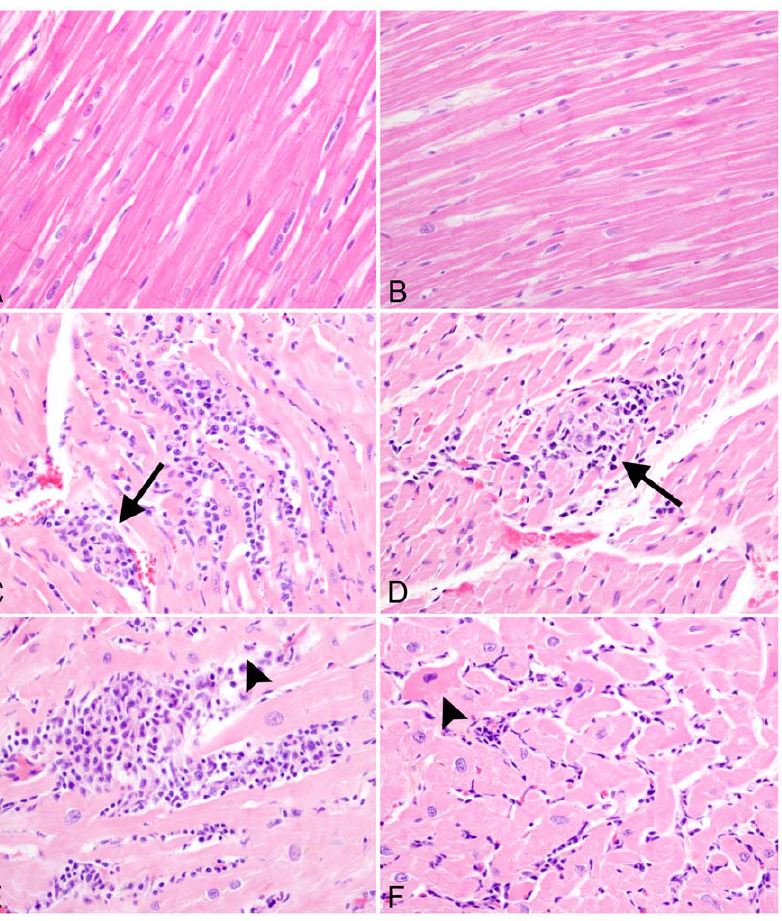
Figure 1. Myocardial lesions are present in all four monkeys that receive CART. H & E stained sections of left ventricle from CD8 + cell- depleted, uninfected control macaque (A) and SIV-positive untreated macaque (B), showing normal cardiomyocytes with cross striations. In contrast, sections of myocardium from monkeys that received CART contained multifocal infiltrates of mononuclear inflammatory cells that separated cardiomyocytes (C), cardiomyocytolysis and necrosis (arrow heads in D and E) and hypereosinophilia with loss of cross striations in cardiomyocytes (arrow in F). Hematoxylin & eosin stain. (400X).